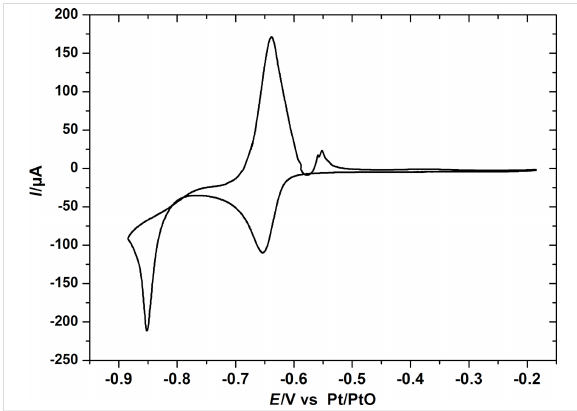
Figure 3: Cyclic voltammogram of Sb deposition on Au(111) in 0.25 mM Sb 2 O 3 /0.5 M H 2 SO 4 electrolyte in the STM cell at 10 mV s − 1 .